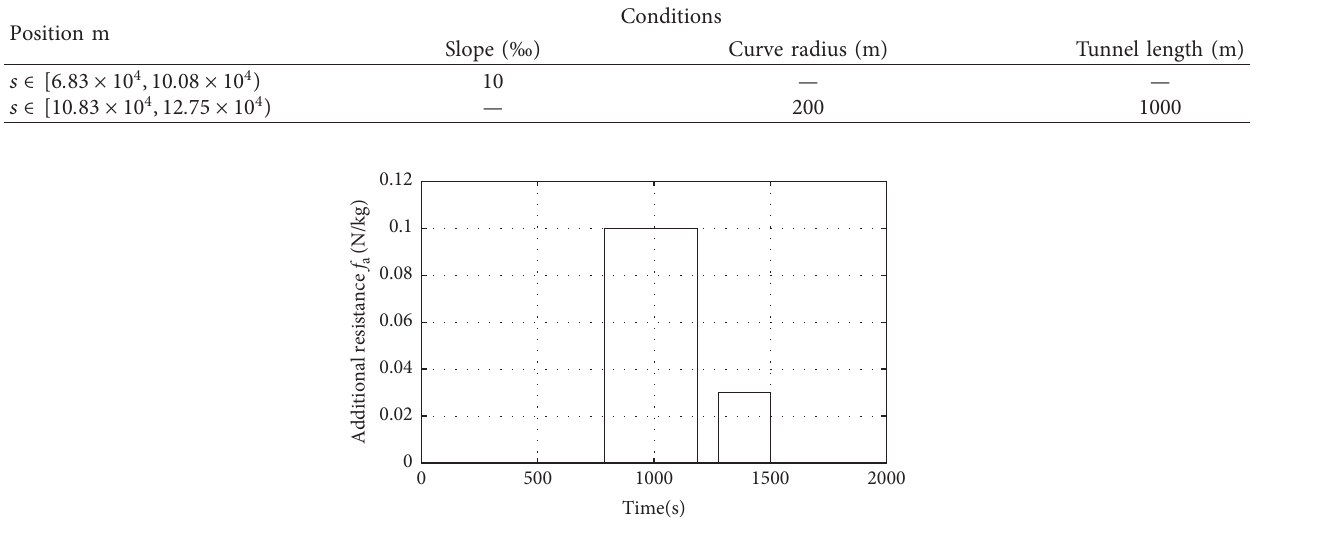
Table 1: Train operation conditions.